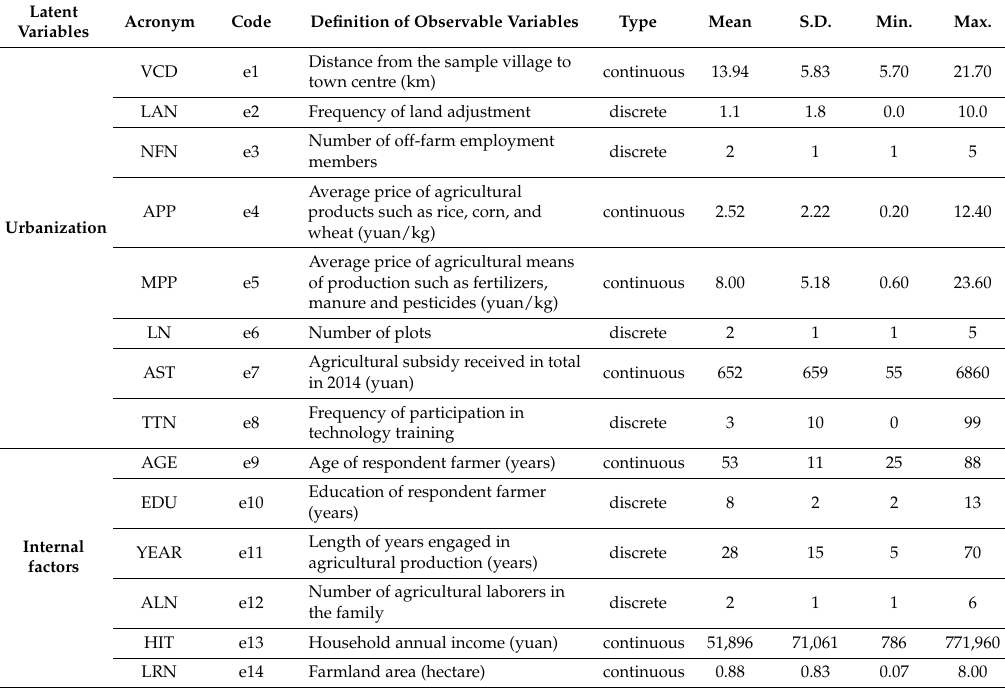
Table 1. Definition and descriptive statistics of latent and observable